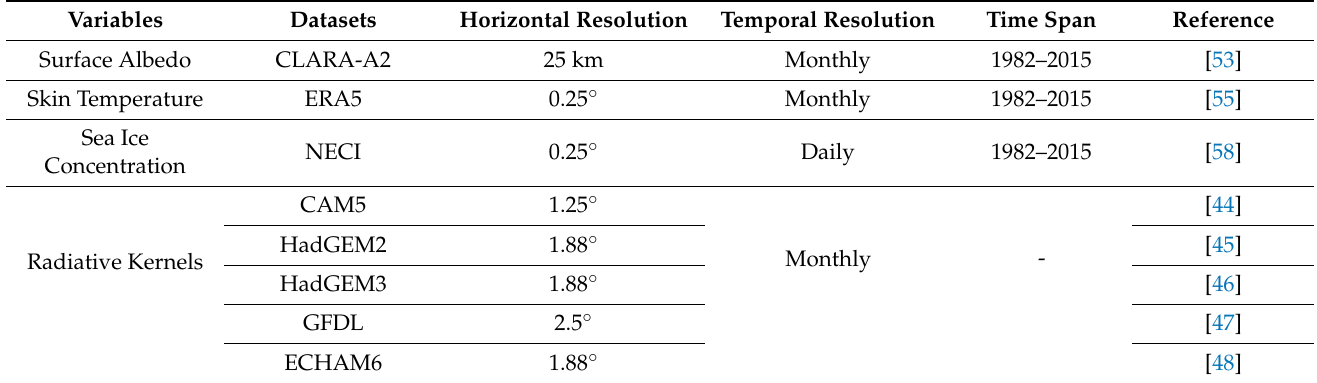
Table 1. Summary of datasets used in the